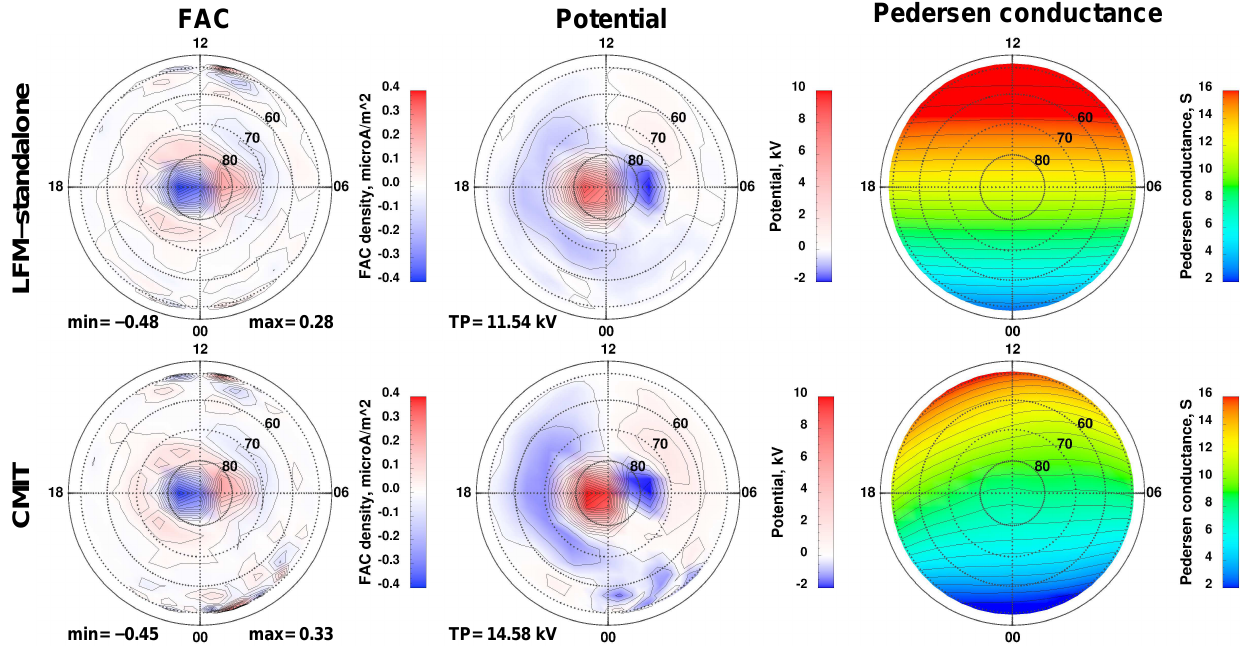
Fig. 7. Three-hour average (16:00–19:00 UT on 16 July 2000) values of the ionospheric field aligned current (1st column), electrostatic potential (2nd column), and Pedersen conductance (3rd panel) of the standalone single resolution LFM (1st panel) and CMIT (2nd panel) simulations.